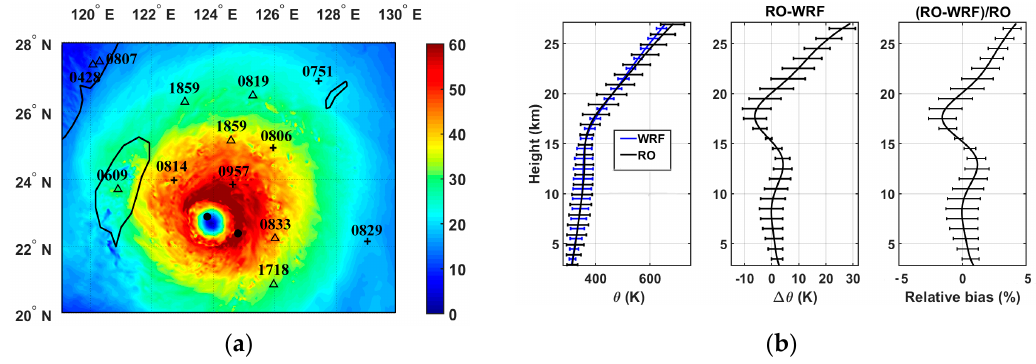
Figure 7. ( a ) Distribution of FormoSat-3/COSMIC (Formosa Satellite Mission-3/Constellation Observing System for Meteorology, Ionosphere, and Climate) RO (radio occultation) data on 6 and 7 August 2015 (triangle and plus sign, respectively) superimposed on horizontal cross section of WRF simulated wind speed (m/s) at a 4 km height on 7 August 0830 UTC. Labels (black) indicate the time in UTC of soundings. Black dots visualize TC Soudelor’s best track at 06:00 and 12:00 UTC. ( b ) Mean profiles of potential temperature and standard deviation (multiplied by 10) at geographical location of COSMIC RO soundings derived from COSMIC RO and WRF data (left), corresponding absolute differences and standard deviation in mean potential temperature (middle), and relative bias (right).